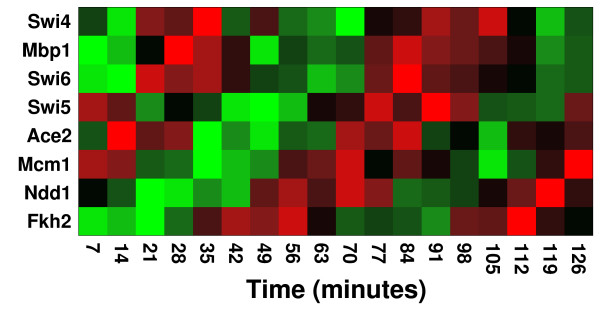
α-coefficients of transcription factors regulating the cell cycle. A heat map of the α-coefficients of the canonical transcription factors during two periods of the cell cycle. Red indicates α > 0 (transcription factor generally bound to over-expressed genes), green indicates α < 0 (transcription factor generally bound to under-expressed genes), and black indicates α = 0. Factors are ordered based on their phase in the long-term asymptotic behavior of our dynamical model. The α-coefficients have been quantile normalized for each factor across the time points.